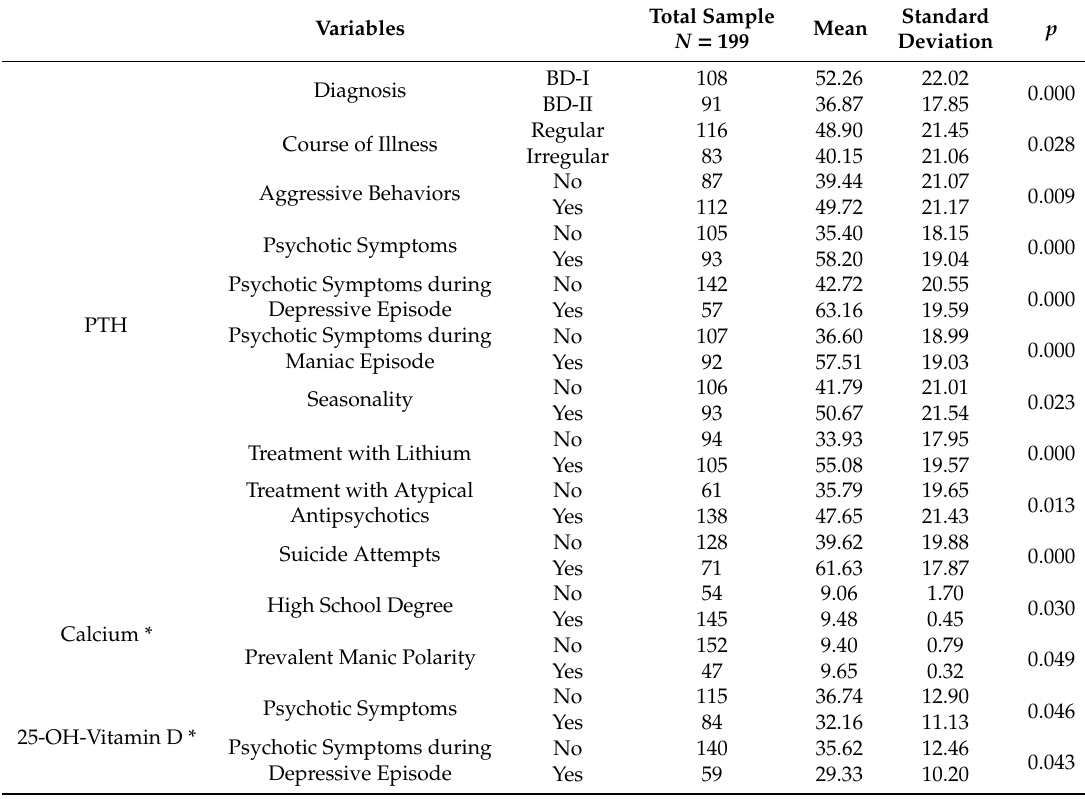
Table 2. Student’s t-test comparing clinical characteristics and calcium metabolism.